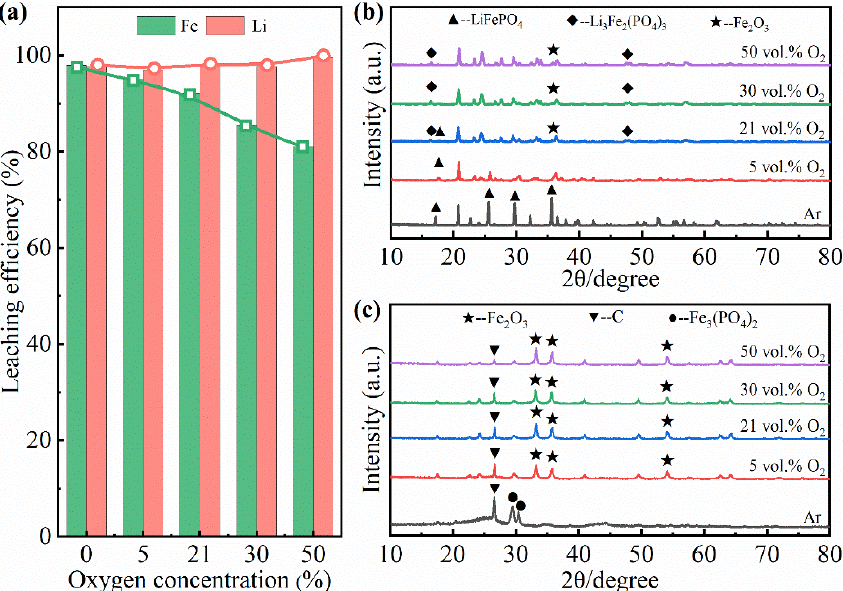
Figure 8. Leaching performance of cathode materials obtained at different oxygen concentrations under the leaching conditions of 1.0 M H 2 SO 4 , S/L = 25 g/L, 70 °C, and 60 min. ( a ) Leaching efficiencies of Fe and Li; ( b ) XRD patterns of calcined cathode materials; ( c ) XRD patterns of sulfuric acid leaching residue.